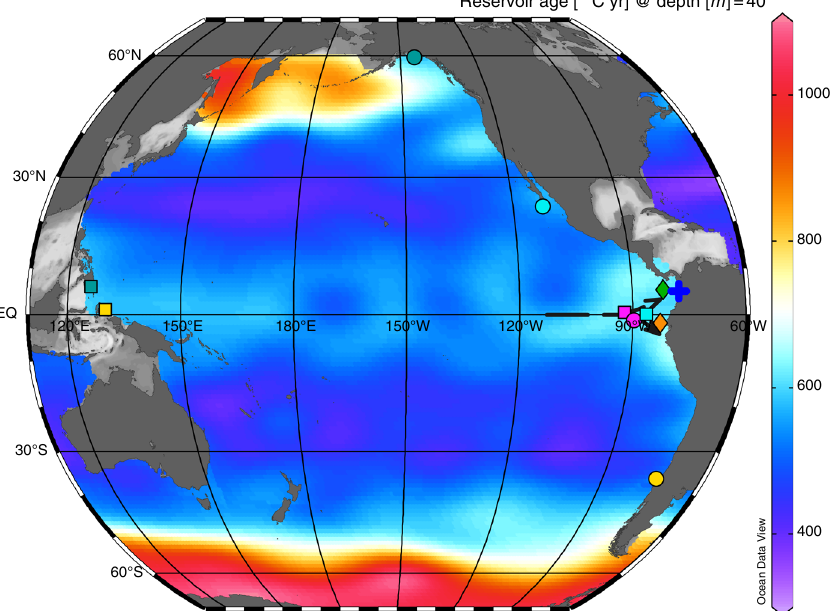
Fig. 1 Locations of cores discussed in this paper. Blue plus: KNR176-GGC17/JPC30 from this study (5.02°N, 77.63°W, 707 m); Dots: intermediate-depth cores MV99-MC19/GC31/PC08 off Baja California (705 m, cyan) 13,32 , VM21-30 near the Galapagos (617 m, magenta) 14 , SO161-SL22 off the Chilean Margin (1000 m, yellow) 15 and EW0408-85JC in the Gulf of Alaska (682 m, dark cyan) 38 ; Squares: mid-depth cores in the EEP (TR163-23, 2730m, magenta 4 ; ODP1240, 2920 m, cyan 5 ) and in the WEP (MD98-2181, 2100 m, dark cyan 1 ; MD01-2386, 2800 m, yellow 8 ); Diamonds: sites of an EEP oceanic Δ p CO 10 and of a plankton tow study in the Panama Basin (dark green) 24 . The sites are plotted with a background of the pre- 2 record (ODP1238, orange) bomb 14 C reservoir age at 40 m (the median depth of the EEP thermocline 21 and also the calci fi cation range of N. dutertrei as determined from the plankton tow study 24 ) from the gridded GLODAP data product 23 . EUC is shown schematically with the black dashed lines with arrow 22 . The symbol colors used in Fig. 3 follows those in this fi gure. Figure made with Ocean Data View